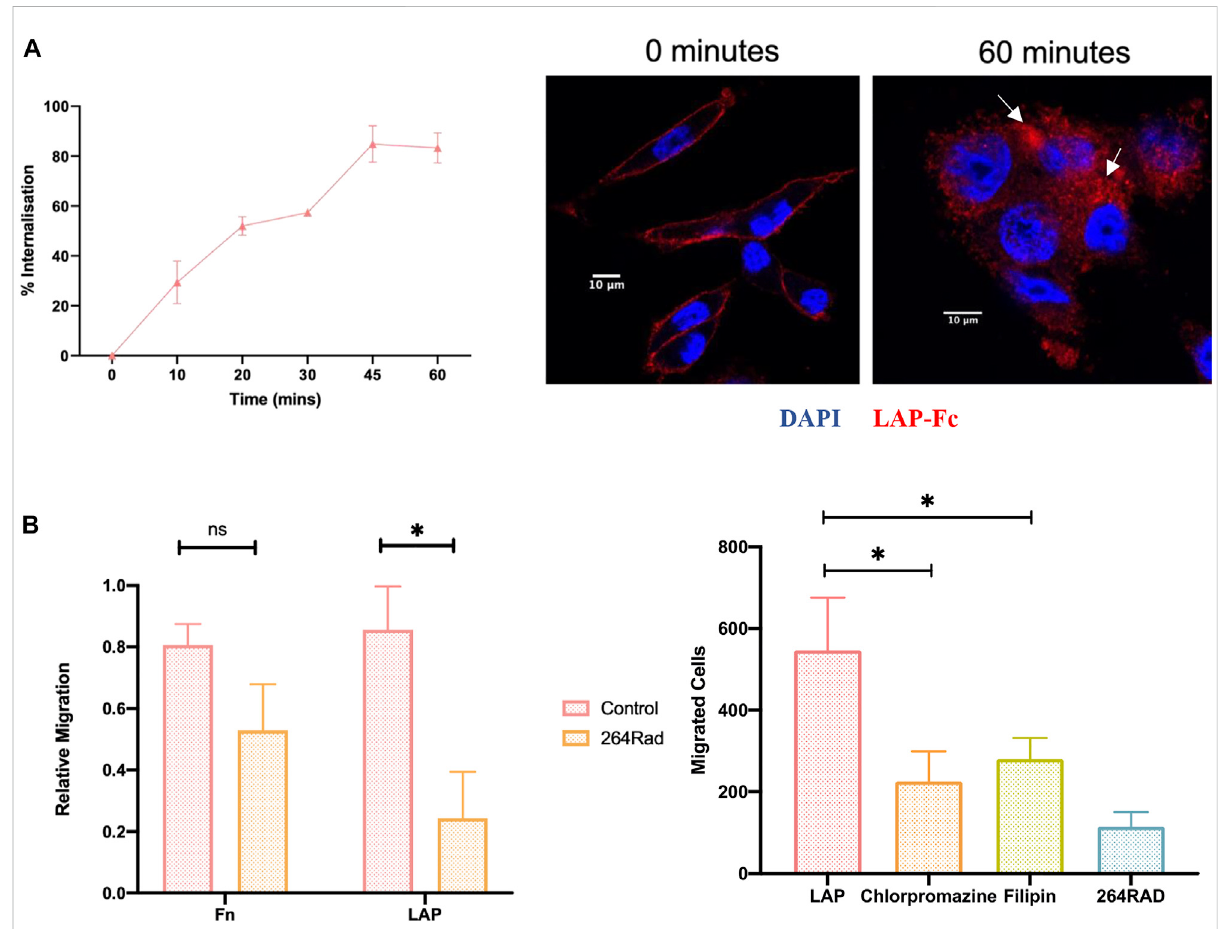
FIGURE 4 Inhibition of ligand-bound α v β 6 endocytosis reduces the rate of cell migration. (A) Internalisation of LAP in C76 cells. (Left) Using fl ow cytometry, C76 internalised 83 ± 10% of LAP-Fc in 60 min Data represents mean ± SD ( n = 3). (Right) LAP-Fc internalisation was also assessed using immuno fl uorescent microscopy, again revealing internalisation of LAP-Fc (red) inside the cell after 60 min. (B) α v β 6 mediated migration. (Left) Transwellswerecoatedwitheither fi bronectin(Fn)orLAP,and50,000C76cellsseededintopofthetranswell,eithertreatedwith264RADoran IGG control. Treatment with 264RAD caused a signi fi cant decrease in migration towards LAP but not Fn. Data represents mean ± SD ( n = 3). (Right) Transwells were coated with 0.5 μ g/ml of LAP and added to the top of the transwell in the presence of chlorpromazine, fi lipin, 264RAD or vehicle control. Signi fi cant reductions in the number of cells migrating through the transwells were observed with chlorpromazine, fi lipin and